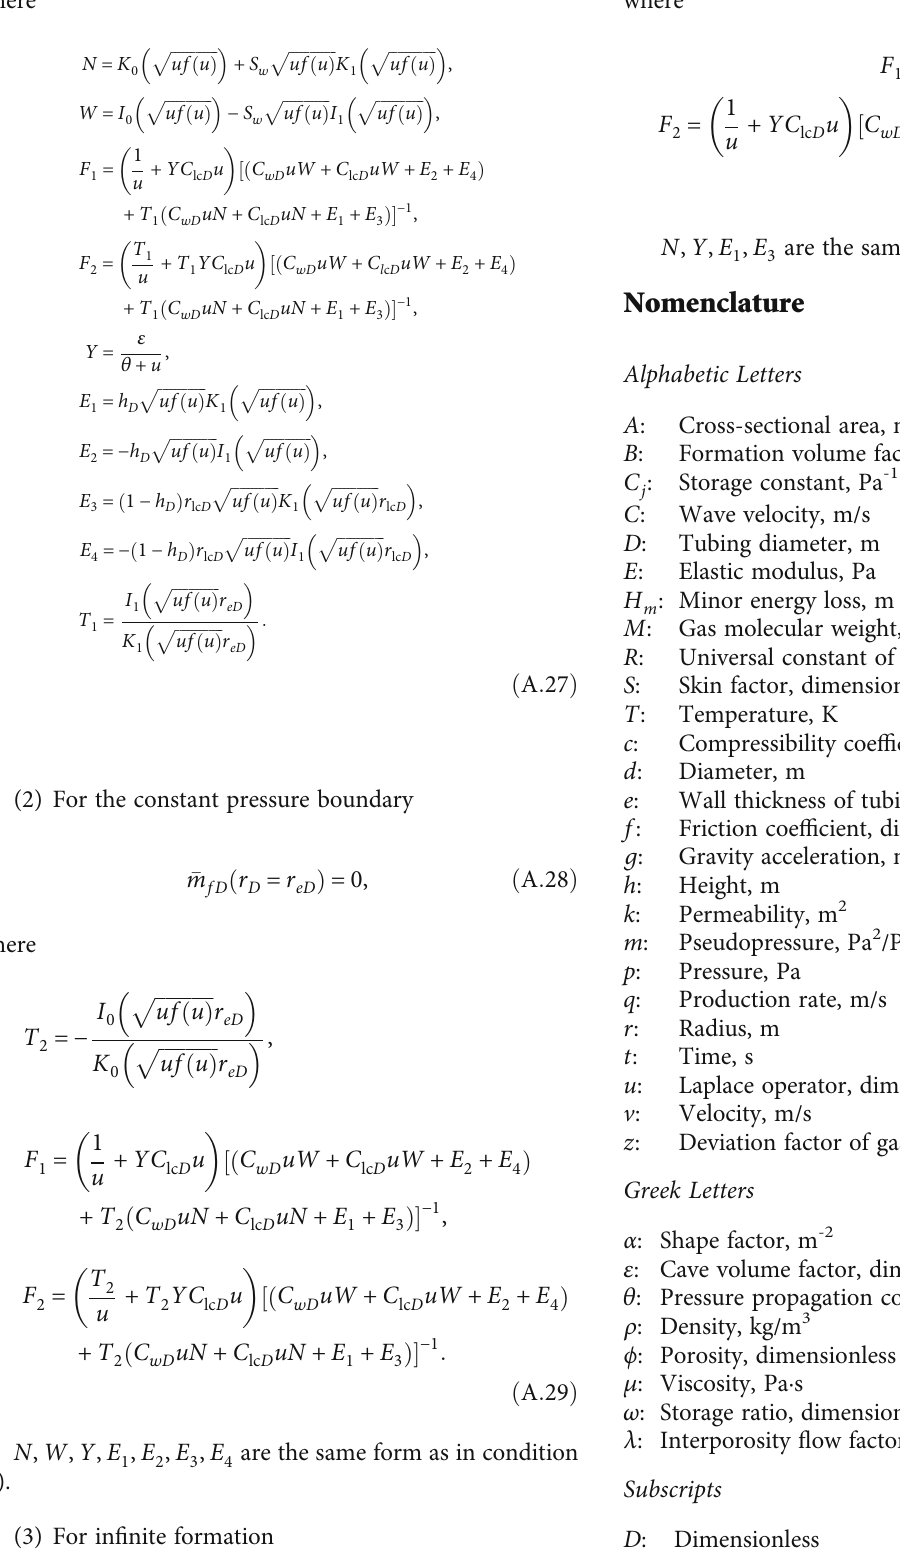
p(cid:9) (cid:10) ffiffiffiffiffiffiffiffiffiffiffiffi uf u ð Þ